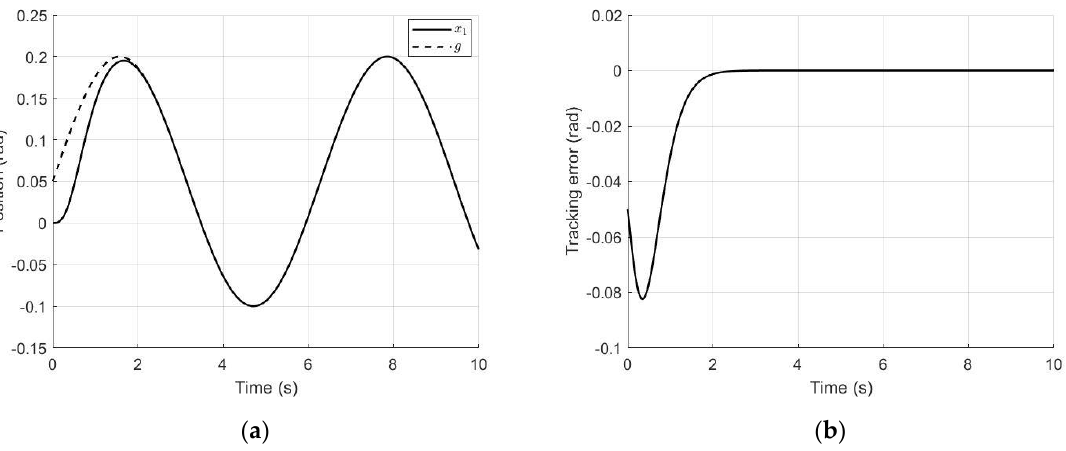
Figure 4. Experiment 1. In ( a ), plots of the reference signal g ( t ) and the output x 1 ( t ) ; in ( b ), plot of the tracking error e 1 = x 1 ( t ) − g ( t ) .